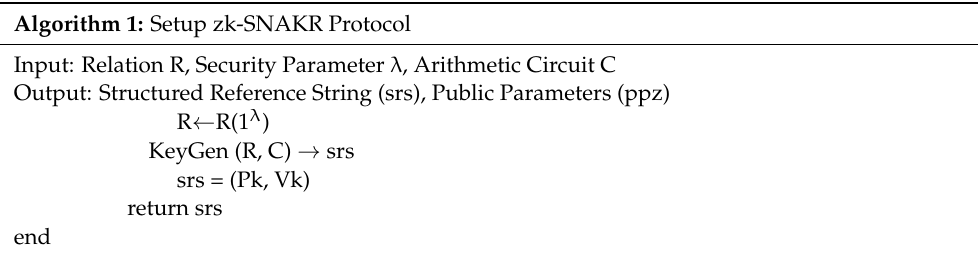
Algorithm 1: Setup zk-SNAKR